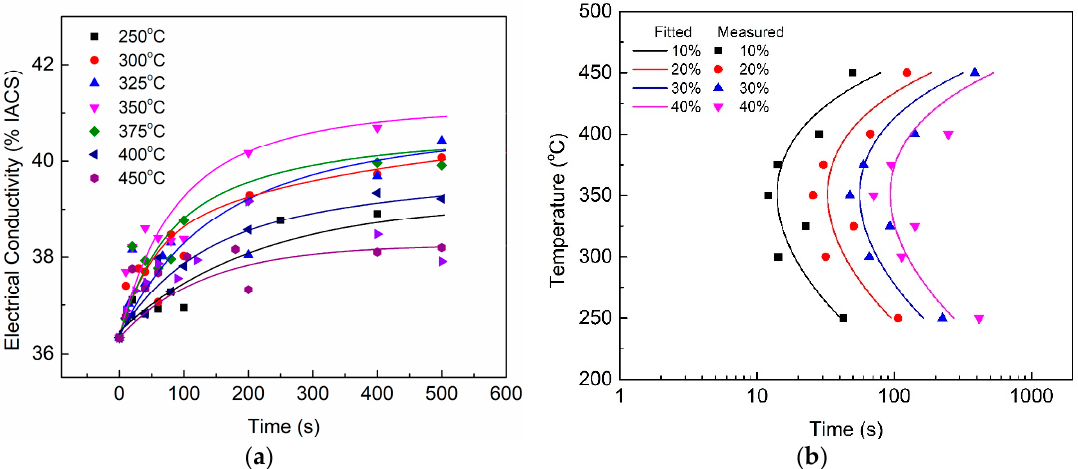
Figure 2. Effect of isothermal treatment on EC of quenched PM casting samples ( a ); TTT diagram of PM casting ( b ). The lines in ( b ) are the fits to the experimental data by using Equation (1).